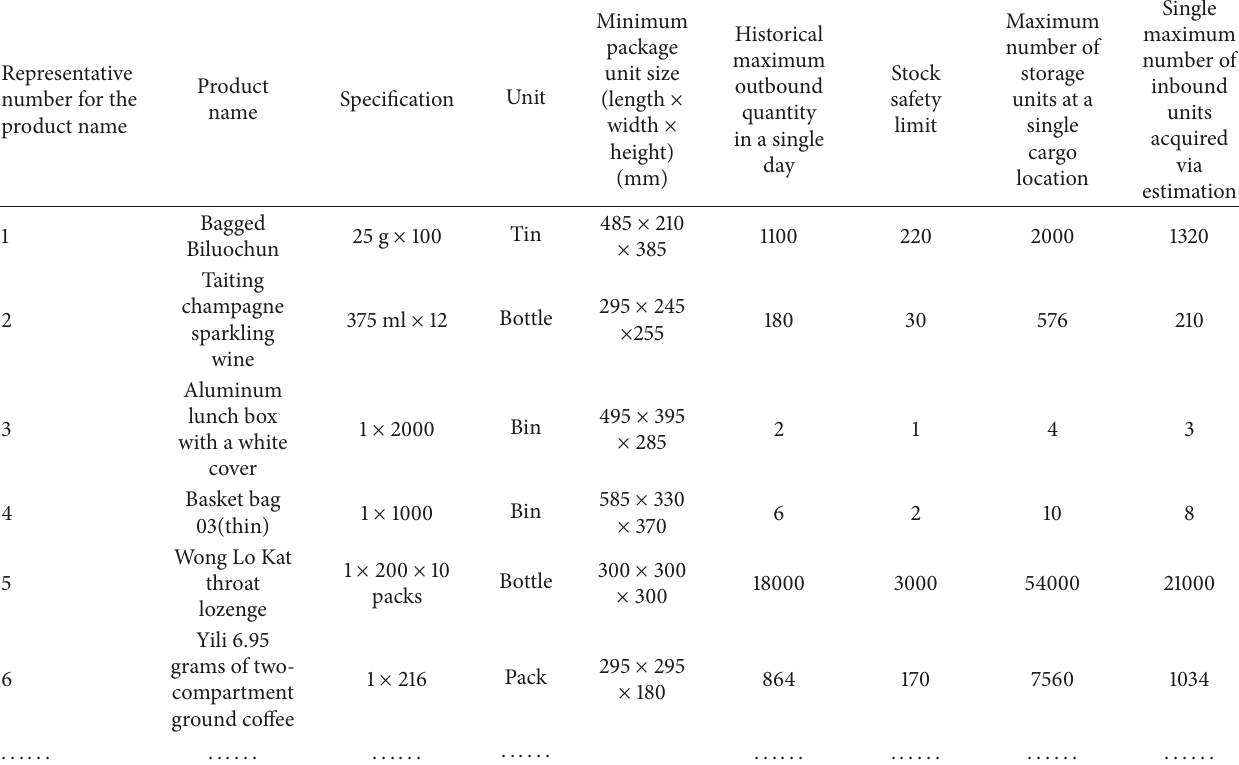
Table 5: Inbound data of outbound goods picked at partial